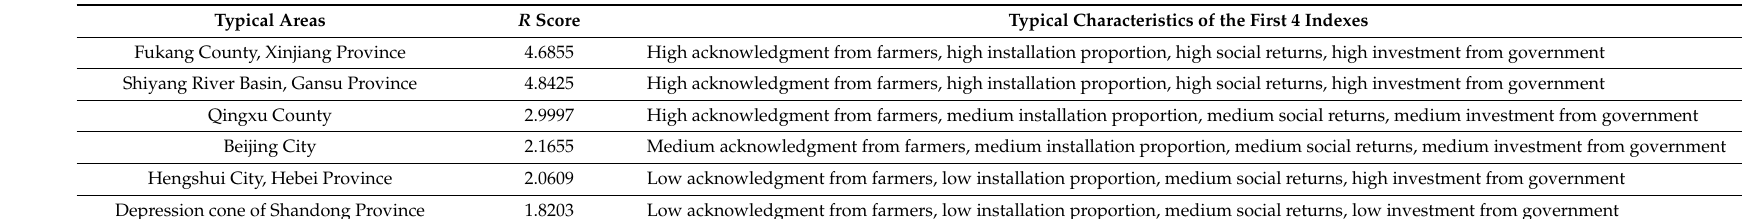
Table 3. Index Classification Test